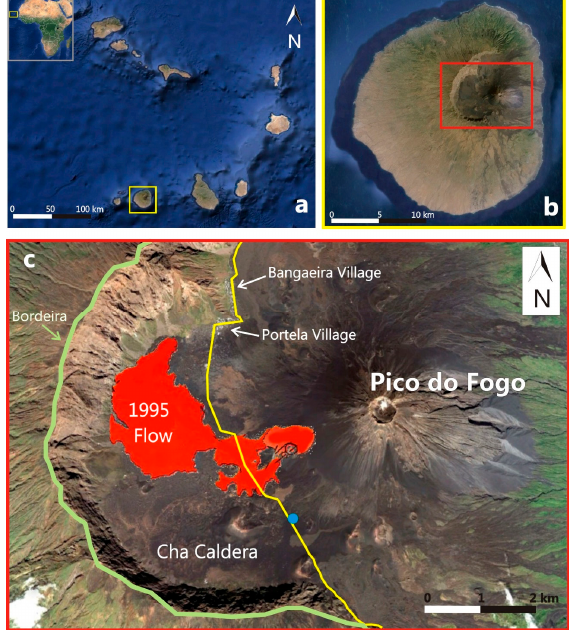
Figure 1. Google Maps with location of: ( a ) Fogo Island (yellow square/rectangle) at Cape Verde Archipelago, western Africa; ( b ) Cha Caldera and Pico do Fogo volcano (inside the red rectangle); and ( c ) Cha Caldera depression and the paved road (yellow line) that crosses it from SE to NW, Pico do Fogo volcano, and the Portela and Bangaeira villages. The blue dot shows the fixed camera location. The 1995 lava flow field is from [39].